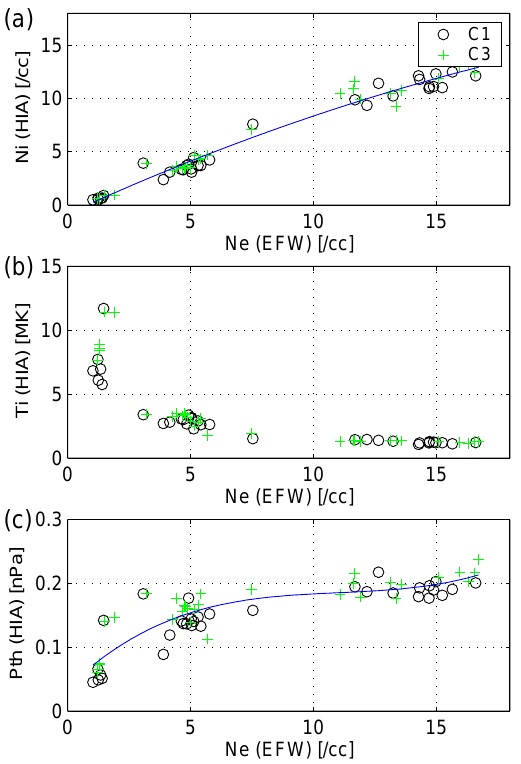
Fig. 2. Relationship from C1 and C3 between ( a ) ion density, ( b ) , ion temperature, and ( c ) plasma pressure measured by the CIS/HIA instrument and electron density estimated from the spacecraft po- tential measurements by the EFW instrument.